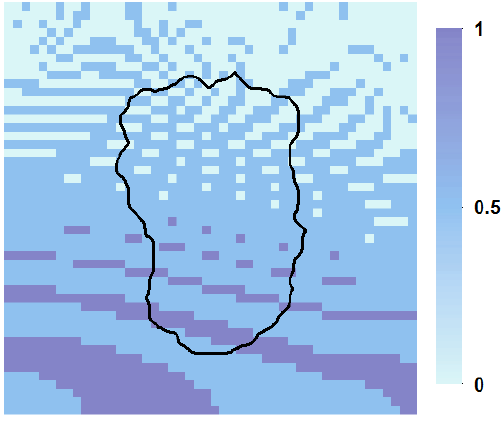
Figure 7. Differences in equilibrium DTWT of Baldry ParFlow.CLM simulations after re-initialization with the adjusted pressure head distribution above the water table and ParFlow.CLM after 28years of baseline spin-up simulations, in meters. The contours of DTWT overestimation are along the direction of flow lines from high-elevation areas towards the catchment